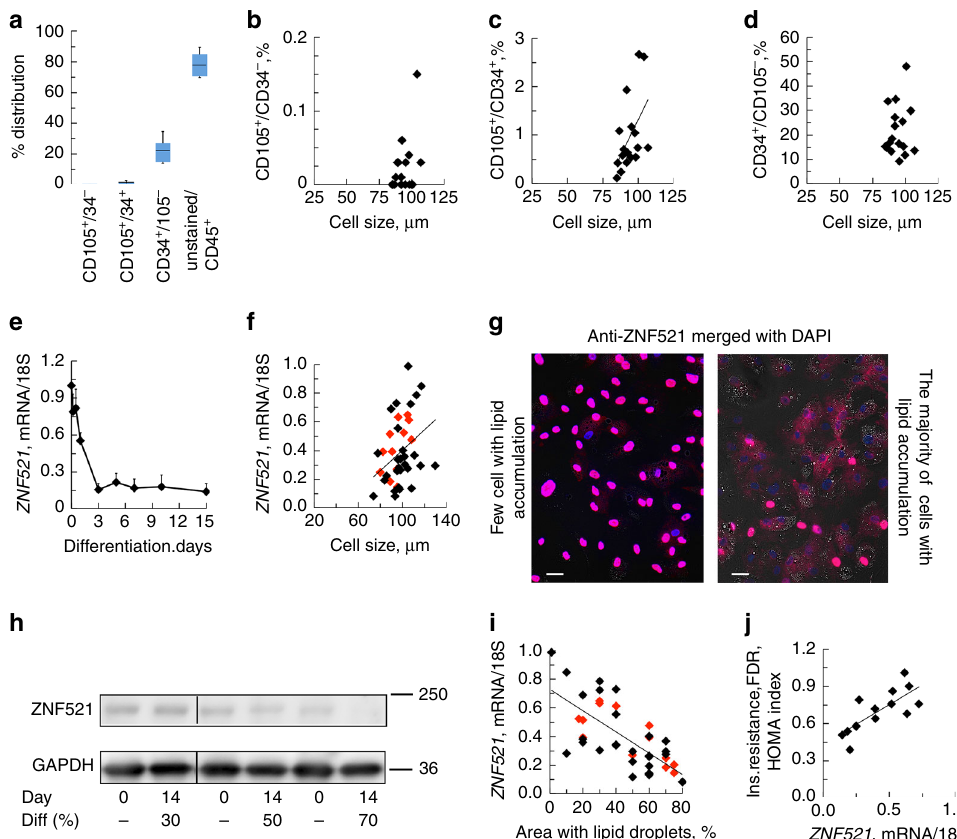
Fig. 1 Elevated expression of ZNF521 in SVF cells is associated with impaired adipogenic differentiation. a FACS analysis of the distribution of SVF cells isolated from human subcutaneous adipose tissue. Range CD105 + /CD34 − 0 – 0.15%, range CD34 + /CD105 + , 0.12 – 2.7%, range CD34 + /CD105